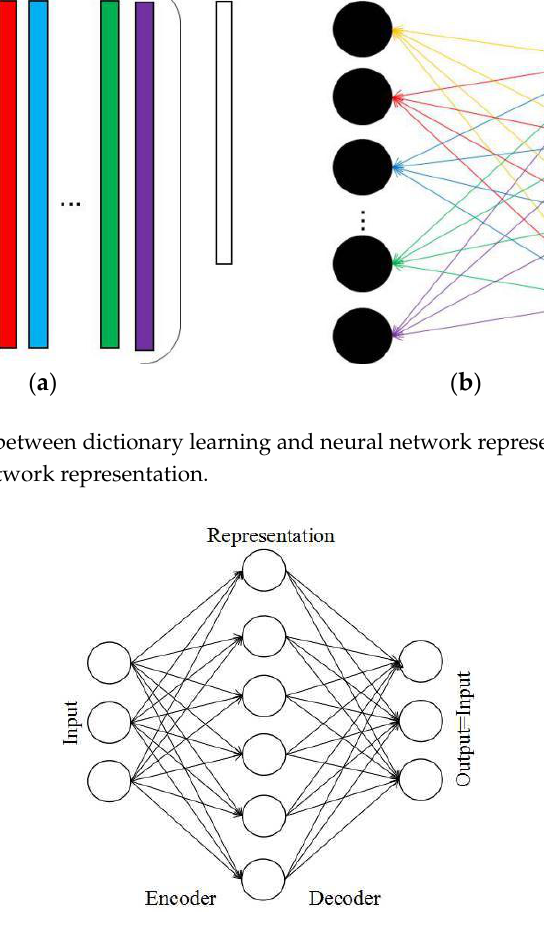
Figure 3. Sparse autoencoder (SAE) structure.